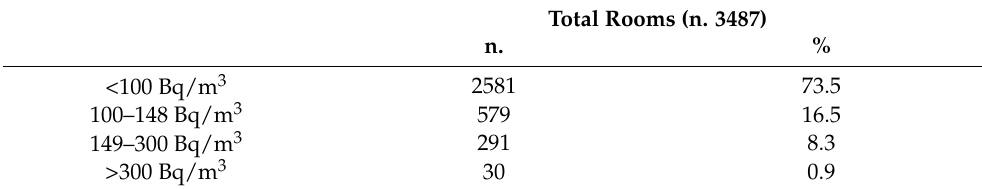
Table 2. Levels of radon in relation to the World Health Organization (WHO) recommended